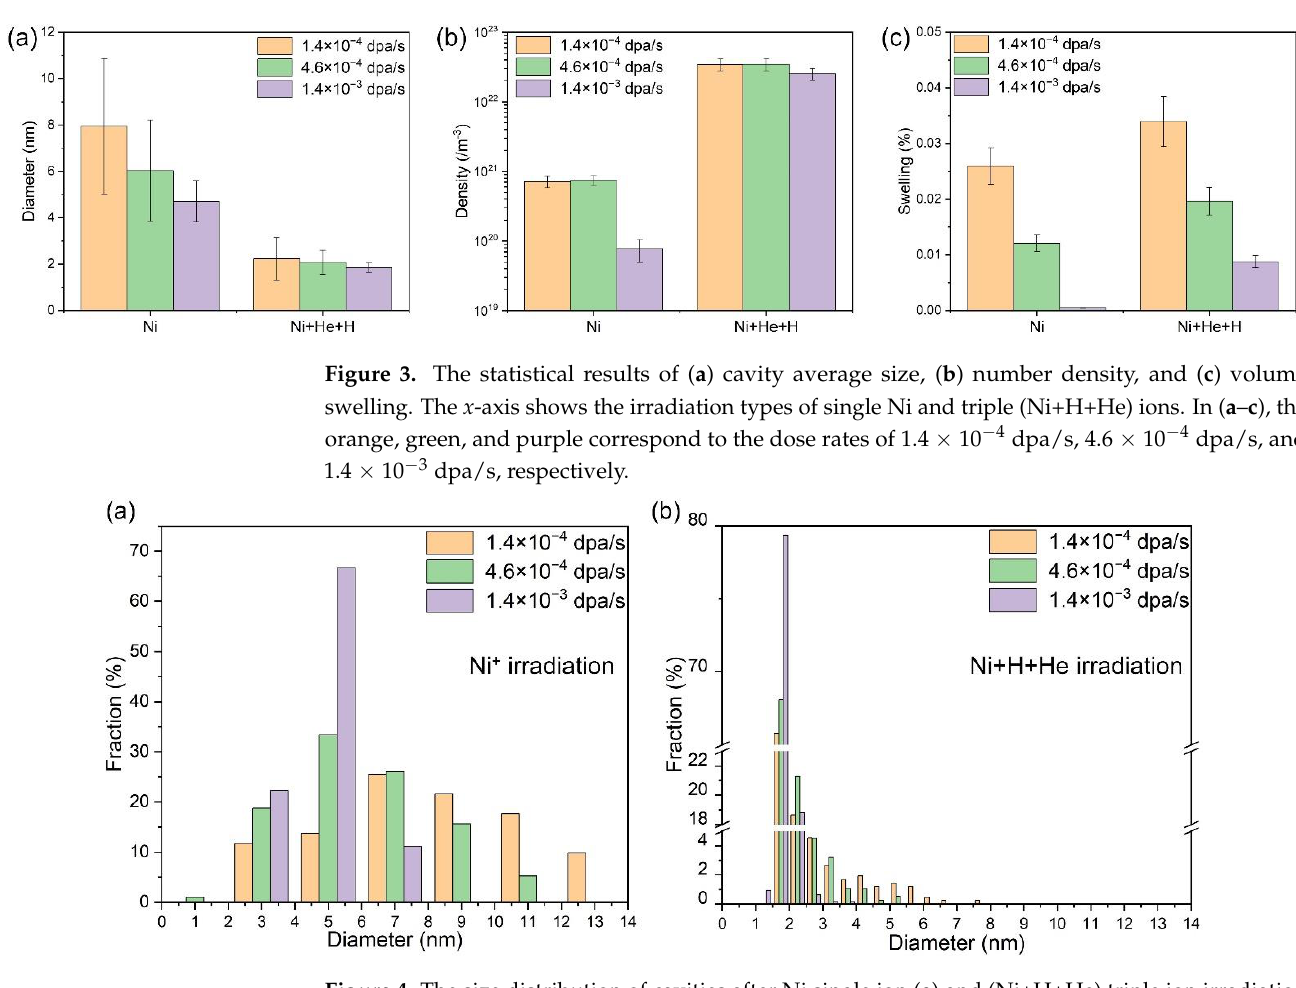
6 of 11 indicated by yellow arrows. The red dashed lines indicate the specimen surface. ( g – i ) are local zoomed images of the red boxed areas in ( d – f ), as indicated by the arrows. Based on the TEM results shown in Figure 2, the cavity size and number densities after single and triple ion beam irradiation were analyzed, respectively, as shown in Fig- ure 3a,b. The Ni + ion irradiation produced cavities with average diameters larger than 4.5 nm at all three dose rates. The average diameters were 7.9 ± 2.9 nm, 6.0 ± 2.2 nm, and 4.7 ± 0.9 nm at dose rates of 1.4 × 10 −4 , 4.6 × 10 −4 , and 1.4 × 10 −3 dpa/s, respectively. This indicates